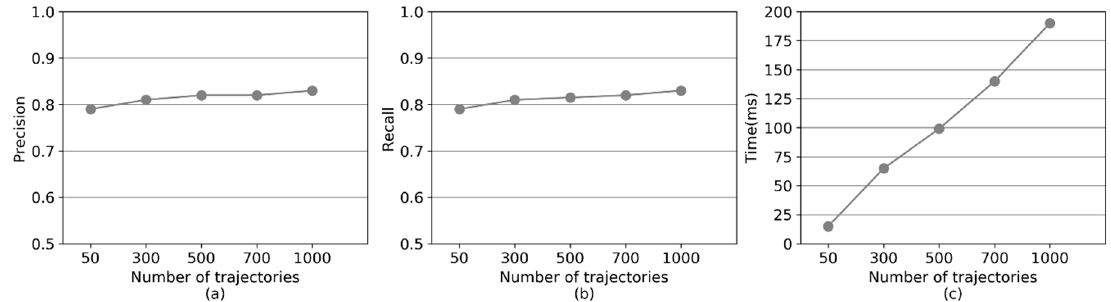
Figure 17. The performance of CMM with different numbers of GPS trajectories. ( a ) Precision. ( b ) Recall. ( c ) Running time.